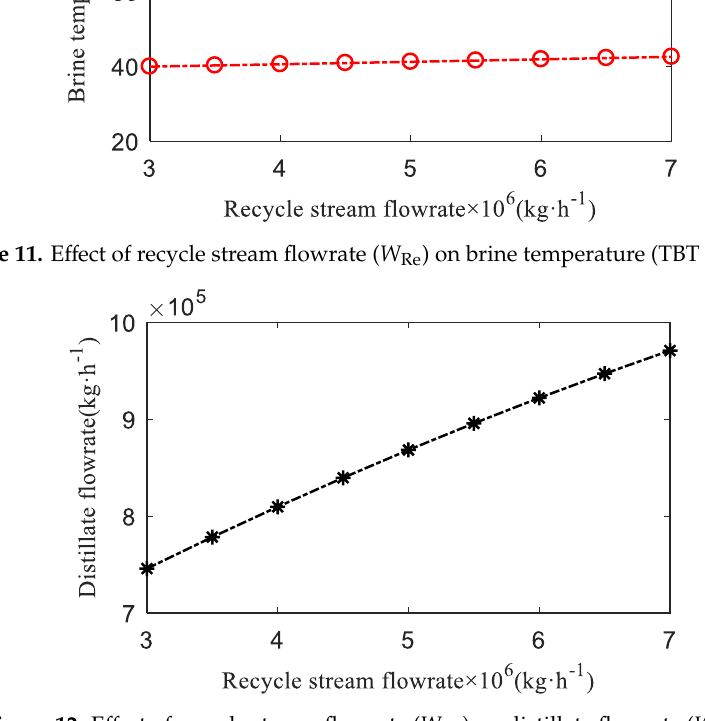
Figure 12. E ff ect of recycle stream flowrate ( W Re ) on distillate flowrate ( W DN ).